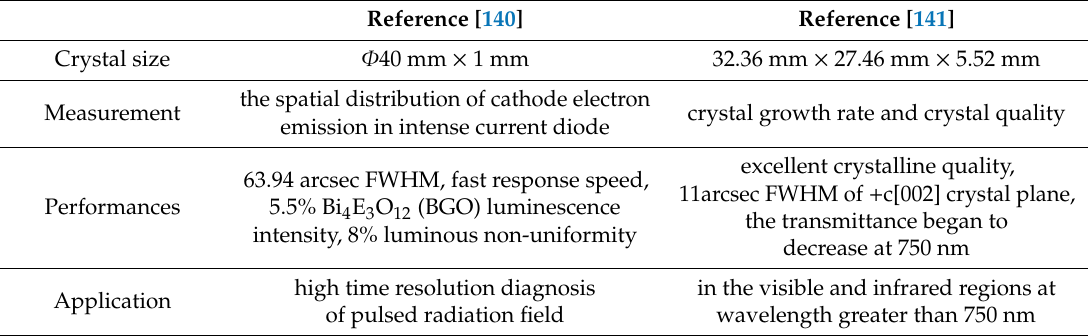
Table 8. The application of ZnO:Ga scintillation crystals prepared by a hydrothermal method in radiation